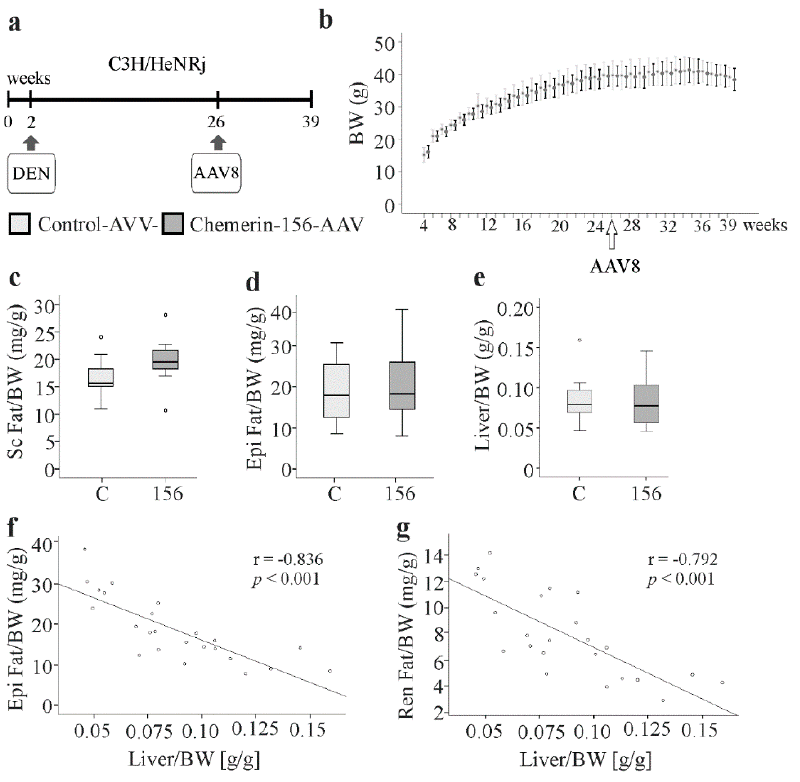
Figure 1. Experimental outline, body weight, and organ weights. ( a ) Experimental outline. ( b ) Body weight (BW) of control-AAV (adeno-associated virus) (C; n = 9) and chemerin-156 (156; n = 12)-AAV infected male mice during the study. Data are shown as mean ± standard deviation. ( c ) Subcutaneous (Sc) adipose tissue weight relative to BW. ( d ) Epididymal (Epi) adipose tissue weight relative to